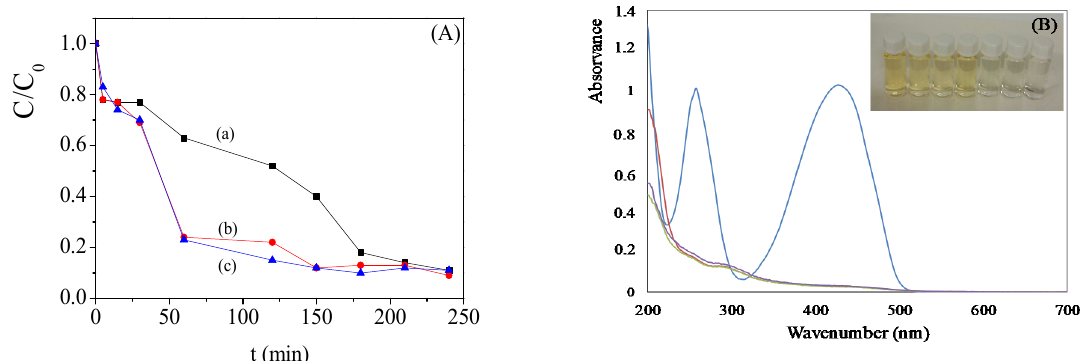
Figure 2. ( A ) C/C 0 vs. reaction time for Fe 4.5 -USY (a), Fe 10 -NaY (b), and Fe 9.3 -Y (c): Reaction conditions: 50 mg of catalyst, V Tar = 250 mL, C 0 = 30 ppm, initial pH = 3.00, C H 2 O 2 = 12 mM, T R = 35 °C and ( B ) UV-vis spectra of the initial Tar solution (blue curve) and after 60 (red curve), 150 (violet curve), and 210 (green curve) min on reaction (inset: the color of the solutions after the degradation of Tar by Fe 10 -NaY, as example).